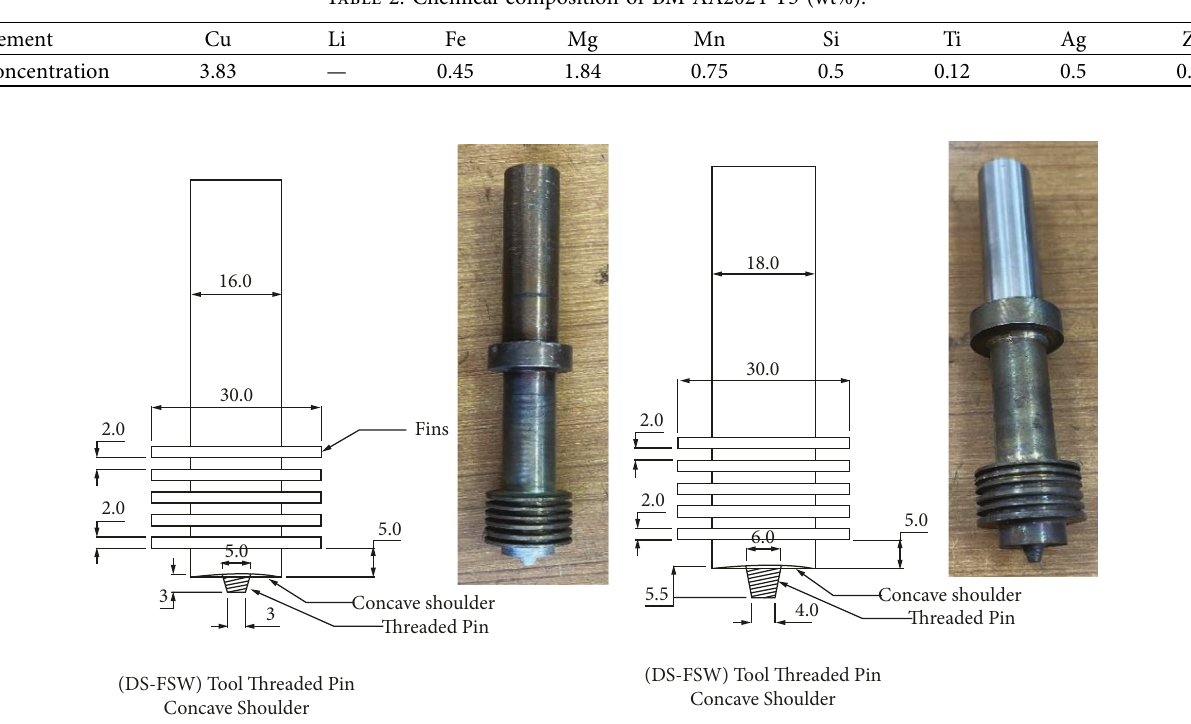
Figure 1: Dimensions and the geometrical design of double side friction stir welding (DS-FSW) and single side friction stir welding (SS- FSW) tools.